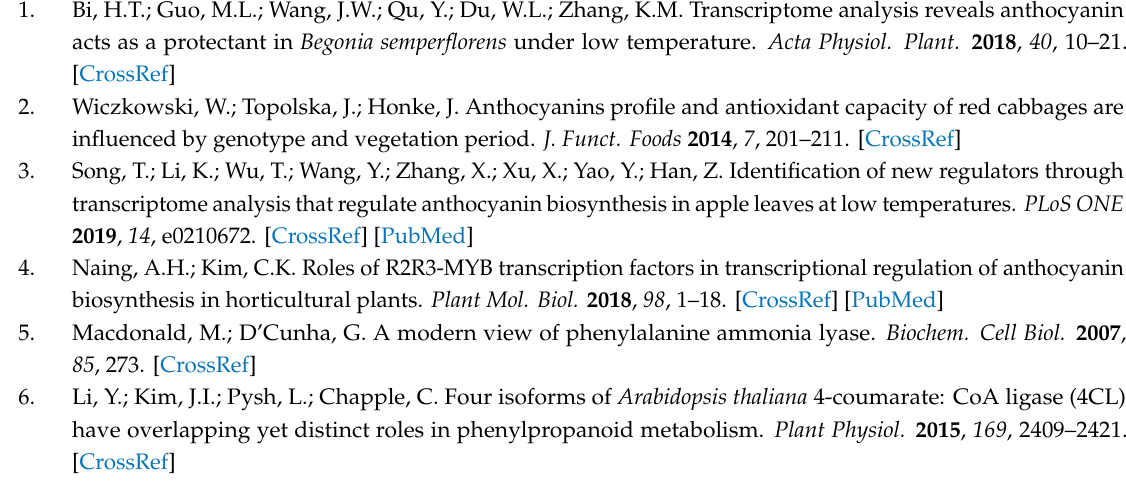
Figure S1: Expression of BrAN11 and BrANL2 in the seedlings of three Chinese cabbages after low temperature treatment. The leaves of Line94S at 25 ◦ C were served as the control; 28-day seedlings were treated at 12 ◦ C for 15 days for the experiment. Values are presented as means ± SD ( n = 3). The di ff erent letters above each column are significantly di ff erent at p < 0.05 by Duncan’s test; Figure S2: The putative interaction networks of regulatory genes involved in anthocyanin biosynthesis in purple head Chinese cabbage. The homologous genes from Chinese cabbage and Arabidopsis are in red and black, respectively. Three R2R3-MYB TFs ‘BrMYB1’, ‘BrMYB2’, and ‘BrPAP1’ are highly homologous to MYB90 (AtPAP2, AT1G66390) and MYB75 (AtPAP1, AT1G56650); Table S1; Relative expressions of anthocyanin biosynthesis in seedlings of Chinese cabbage under 25 ◦ C and 12 ◦ C conditions. Plants of three lines were grown under a 12-h light photoperiod at 25 ◦ C, 125 mmol m − 2 s − 1 ; 28-day seedlings were kept at 12 ◦ C for 15 days, and the seedlings that stayed at 25 ◦ C with same light condition were treated as the control. The means are values ± SD. The di ff erent letters in each line are significantly di ff erent at p < 0.05 by Duncan’s test; Table S2: Genes involved in anthocyanin biosynthesis in B. rapa . The information was collected from the Brassica database. At , Arabidopsis ; Br , Brassica ; Table S3; Primers for the qRT-PCR analysis in Chinese Cabbages. a: Sequence length was acquired according to the BRAD